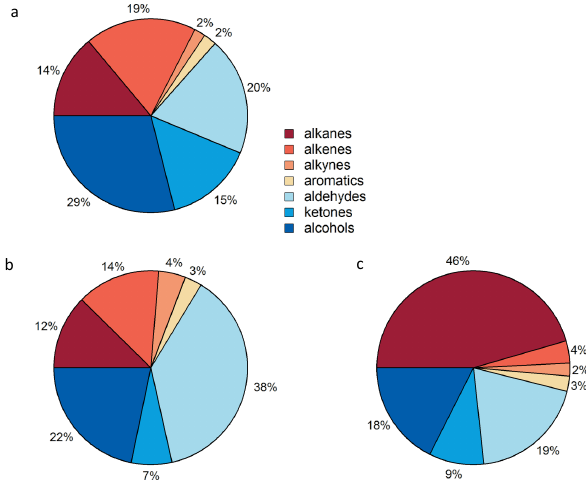
Fig. 11. Measured NMOC distributions based on the sums of mix- ing ratios in each compound class from selected ARCTAS observa- tions in fresh (a) Canadian BB, (b) Californian BB and (c) urban emissions; (a) and (b) are the initial conditions used for the NCAR Master Mechanism box